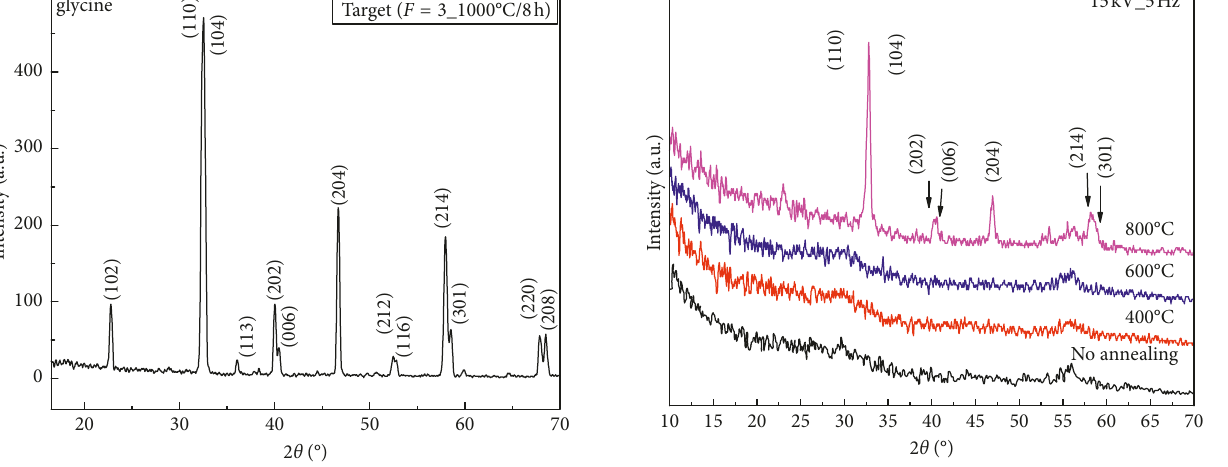
3 thin films deposited before